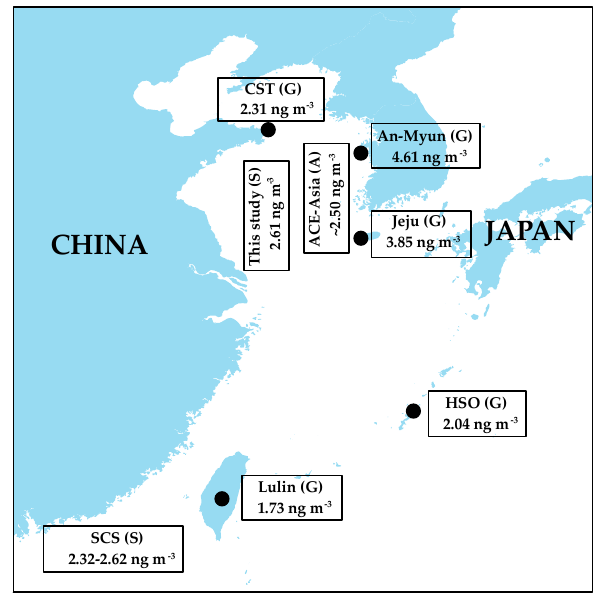
Fig. 2. Comparisons of atmospheric Hg measurements based on various platforms around coastal/open ocean environments of East Asia. (G): ground measurement; (A): airborne measurement and (S): shipborne measurement. CST: Ci et al., (2011b); ACE- Asia: Friedli et al. (2004); An-Myun: Nguyen et al. (2007); Jeju Island: Nguyen et al. (2009); HSO: Jaffe et al. (2005); Lulin: Sheu et al. (2010); SCS: Fu et al. (2010) and Xia et al. (2010). 123.50° E).